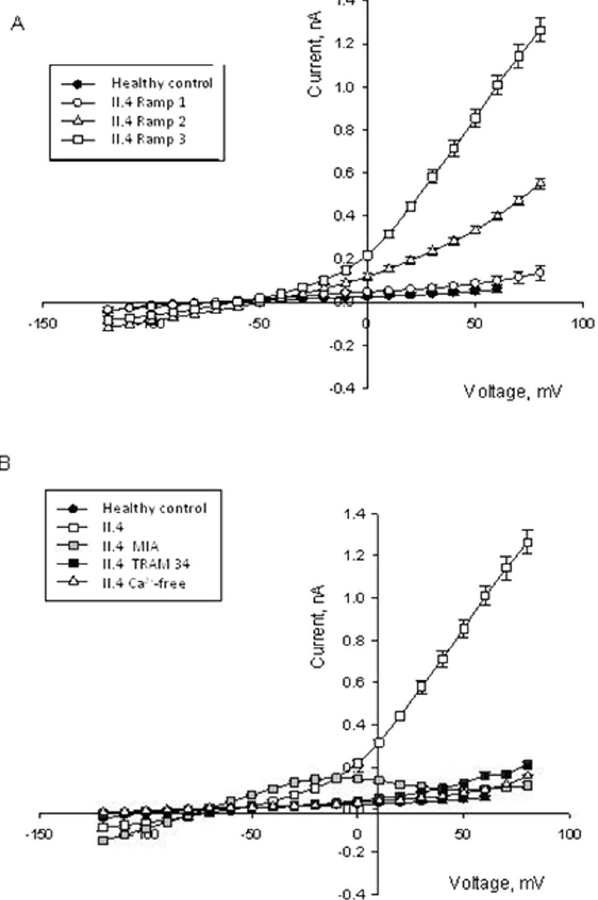
Figure 4. Current-voltage plots for the erythroid precursor cells of the healthy controls (n = 17, black circles) and II-4 patient (open or grey symbols). ( A ) Cells were exposed to a ramp protocol three times in a row. Each next hyperpolarization-depolarization cycle was followed by an increase in current at positive potentials in the EPCs of II.4 patient (n = 24, 19 and 12 for the ramps 1, 2 and 3), whereas for the cells derived from healthy donors it was never the case. ( B ) Increase in electric current at positive potential in cells of patient II.4 caused by repetitive ramp protocol application could be blocked by pre-treatment of cells with 15 µ M methyl isobutyl amiloride (MIA, grey squares, n = 14), 15 µ M TRAM-34 (black squares, n = 7) or omission of the extracellular Ca 2 + (open triangles, n = 14). All I/V curves presented in the panel represent the values obtained for the third ramp protocol. Data are shown as mean ±